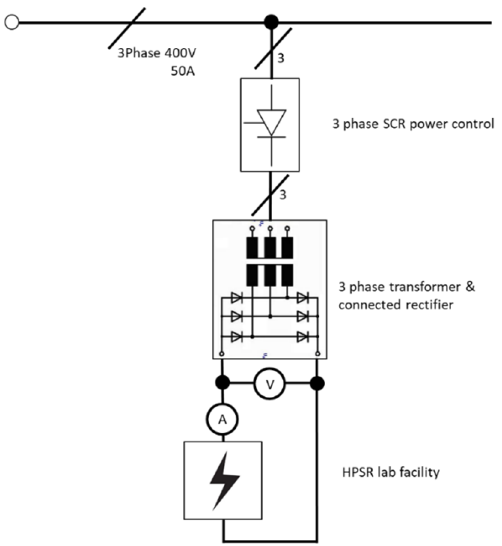
Figure 11. The simple circuit diagram with the use of a silicon-controlled rectifier (SCR) and the positions of measurement for the HPSR lab facility.